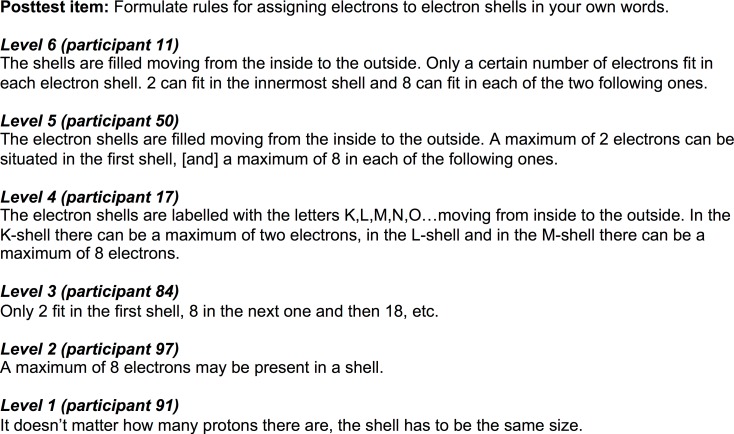
Posttest answers that correspond to the six levels of the rating scale (translated from German).